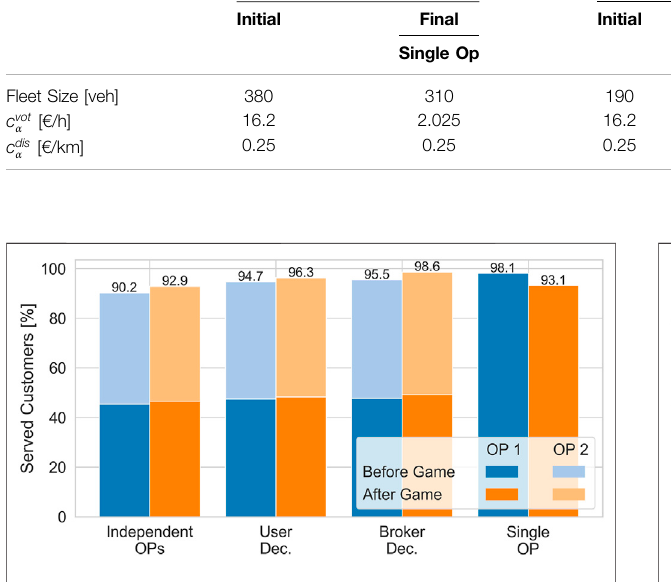
TABLE 1 | Operator service parameters before (Initial) and after the game (Final). Parameter